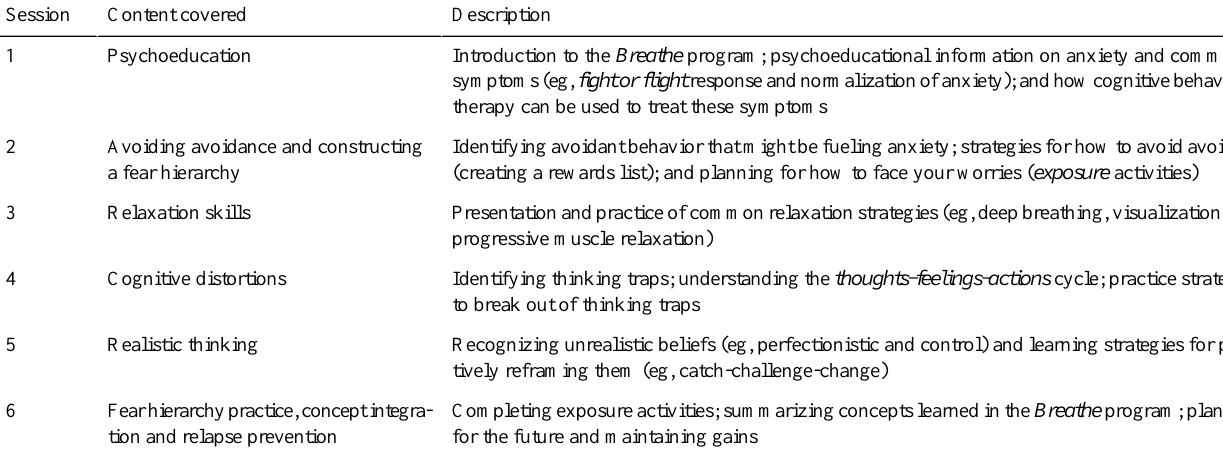
Table 1. An overview of the content presented in the six sessions of the Breathe program.